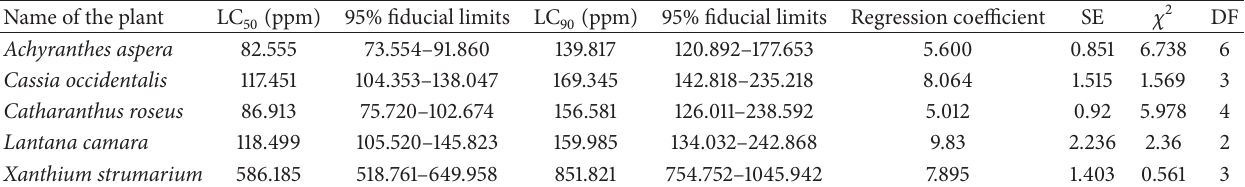
Table 2: Larvicidal potential of the leaf hexane extracts of the selected plant species against early fourth instars of dengue vector Aedes aegypti . Name of the plant